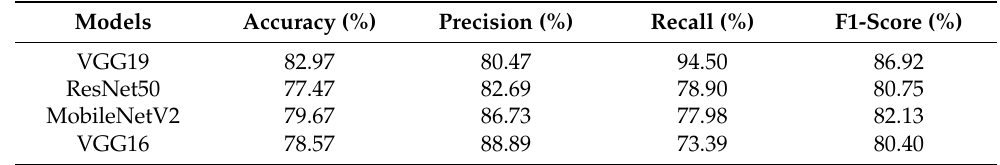
Table 6. Models with transfer learning from ImageNet for disc state classification without ROI or